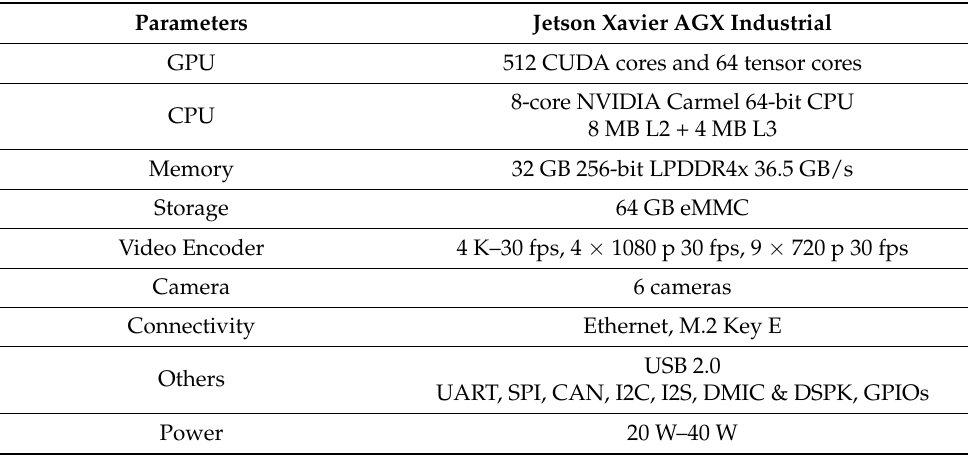
Table 5. Jetson Xavier AGX Industrial technical